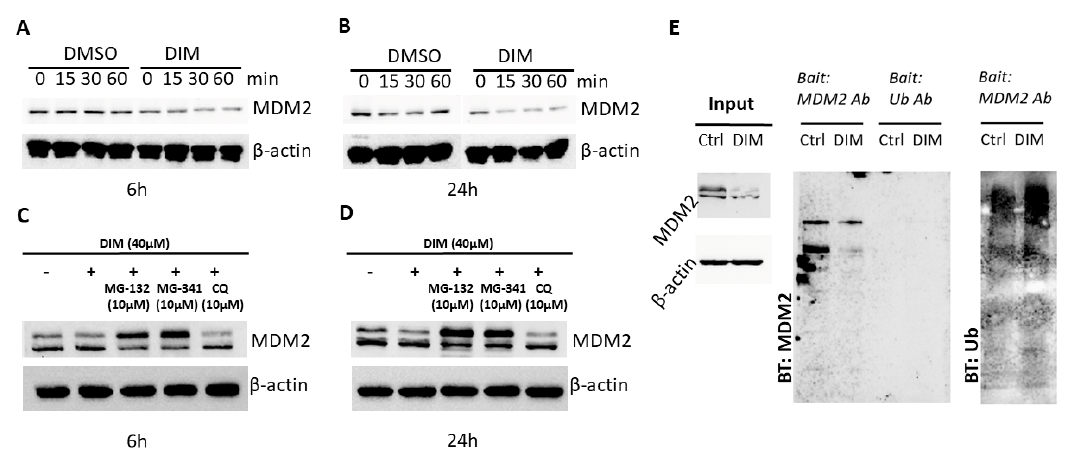
Figure 2. DIM induced proteasome-mediated degradation of MDM2 in HCT-116 cells. HCT-116 cells were pretreated with 40 µ M DIM for ( A ) 6 h and ( B ) 24 h before cycloheximide (CHX) (at a final concentration of 10 µ g / mL) was added into the culture. Cells were then lysed at the indicated time points after CHX application. ( C , D ) HCT-116 cells were treated with various proteasome or autophagy inhibitors. HCT-116 cells were incubated for ( C ) 6 h and ( D ) 24 h with 40 µ M DIM and 10 µ M of the indicated inhibitor. Cell lysates were analyzed by Western blotting with the indicated antibodies. ( E ) HCT-116 cells were treated with 40 µ M DIM for 24 h. Co-immunoprecipitation was performed using an anti-MDM2 antibody, and the immunoprecipitates were blotted with anti-MDM2 or anti-ubiquitin antibodies.